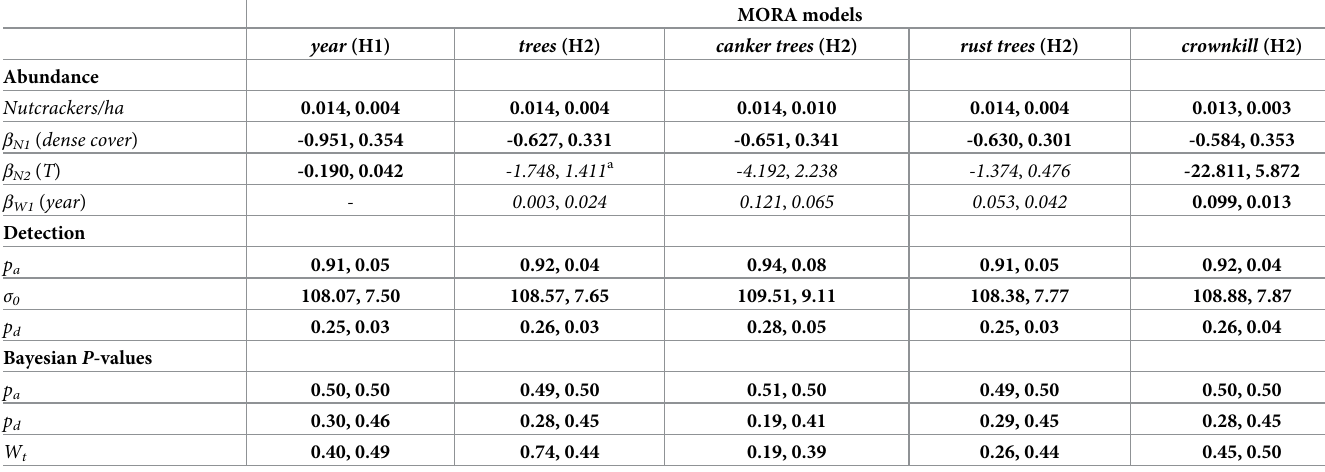
Table 6. Mean and standard deviation of parameter estimates and model diagnostics for temporal models of Clark’s nutcracker density in Mount Rainier National Park. Models are listed by associated hypothesis (H in Fig 2) and distinguishing effect ( T ).